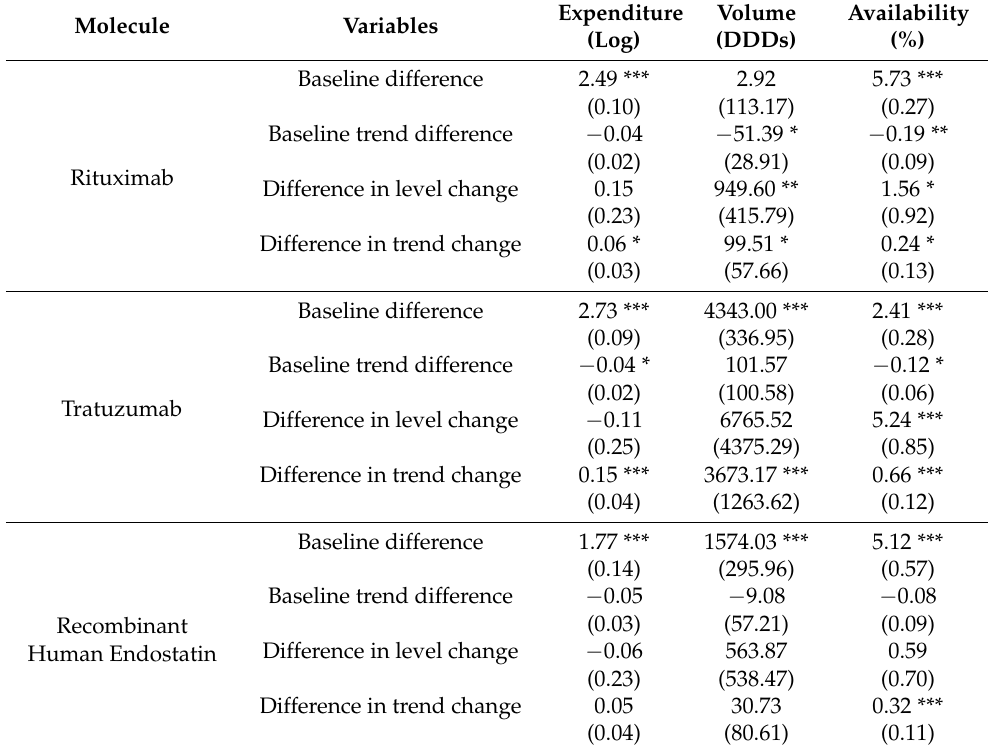
Table 3. Changes in the level and trend of the expenditure, volume, and availability for three targeted anticancer drugs and the comparison group.